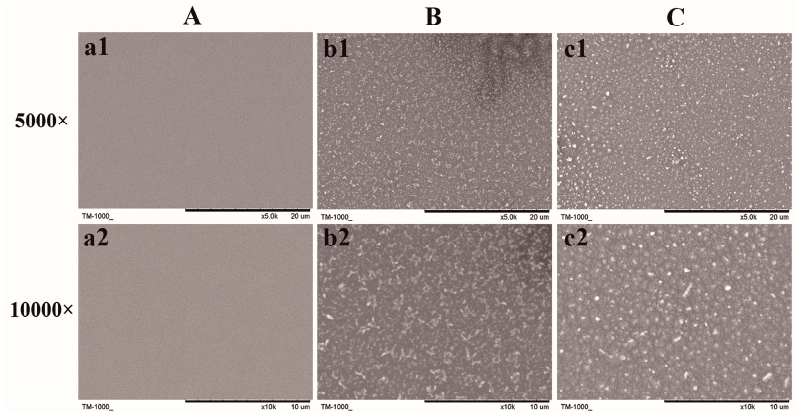
Figure 3. Scanning electron microscopy (SEM) images of the bare surface ( A ), (HA/DNA) 4 films ( B ) and (HA/DNA) 8 films ( C ); ( a1 ), ( b1 ) and ( c1 ): 5000×; ( a2 ), ( b2 ) and ( c2 ): 10,000×.